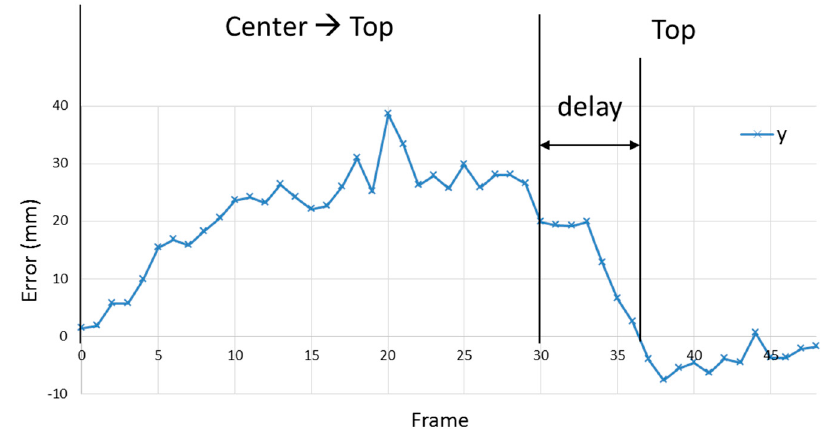
Figure 13. Translation errors in y when the participant stopped his head after moving his head from the center to the top.